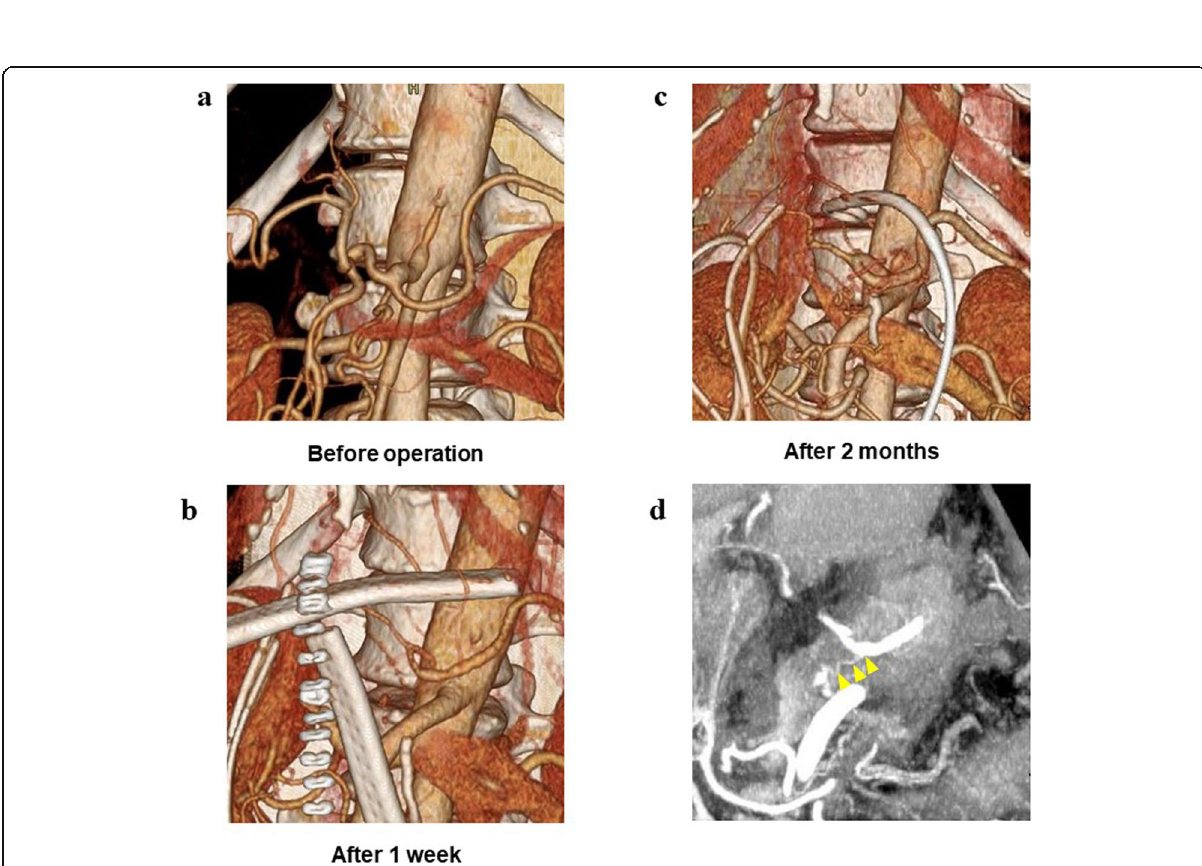
Fig. 3 Time course of 3D CT angiography. a Preoperative CT; stenosis of the root of celiac artery. b CT at 1 week after the operation; absence of the root of celiac artery and the reduction of liver blood flow. c CT at 2 months after the operation; collateral circulation from dorsal pancreatic artery with recovery of liver blood flow. d Dorsal pancreatic artery flowed into splenic artery (1 week after the